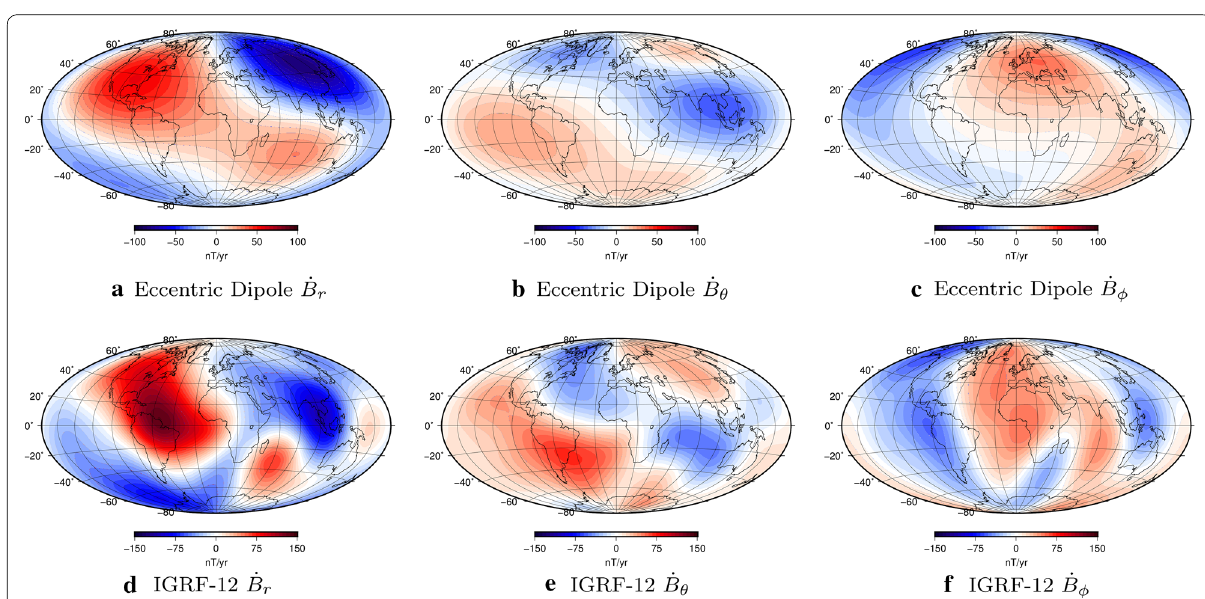
Fig. 7 (Top) Secular variation due to translation and rotation of the eccentric dipole, for the first half of 2014 at 500 km altitude, using CHAOS-6 to compute the ED parameters. (Bottom) Secular variation computed from the IGRF-12 model (2015–2020). Both represented as ˙ B r , ˙ B θ and ˙ B φ in nT/ year